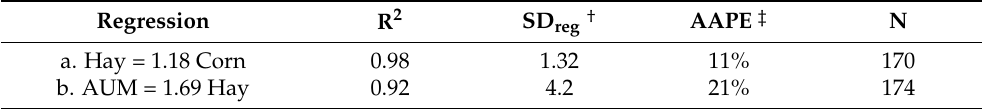
Table 9. Use of National Soils Information System expected corn yield to predict hay yield (MT · ha − 1 ) and hay yield to predict animal unit months of grazing (AUM · ha − 1 ).